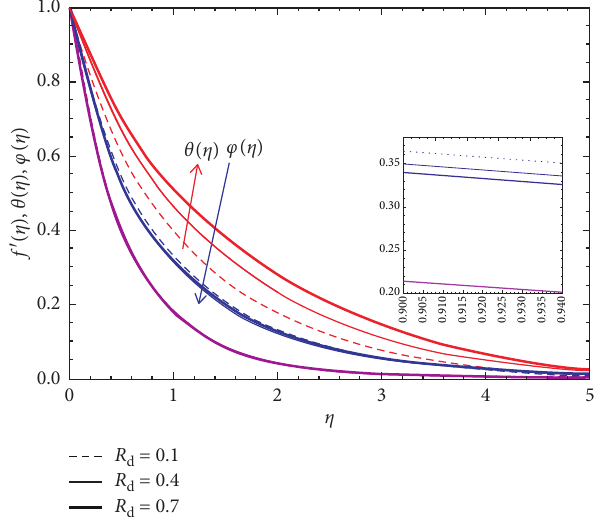
Figure 7: Effects of thermal radiation parameter R gradient, temperature, and concentration profiles.